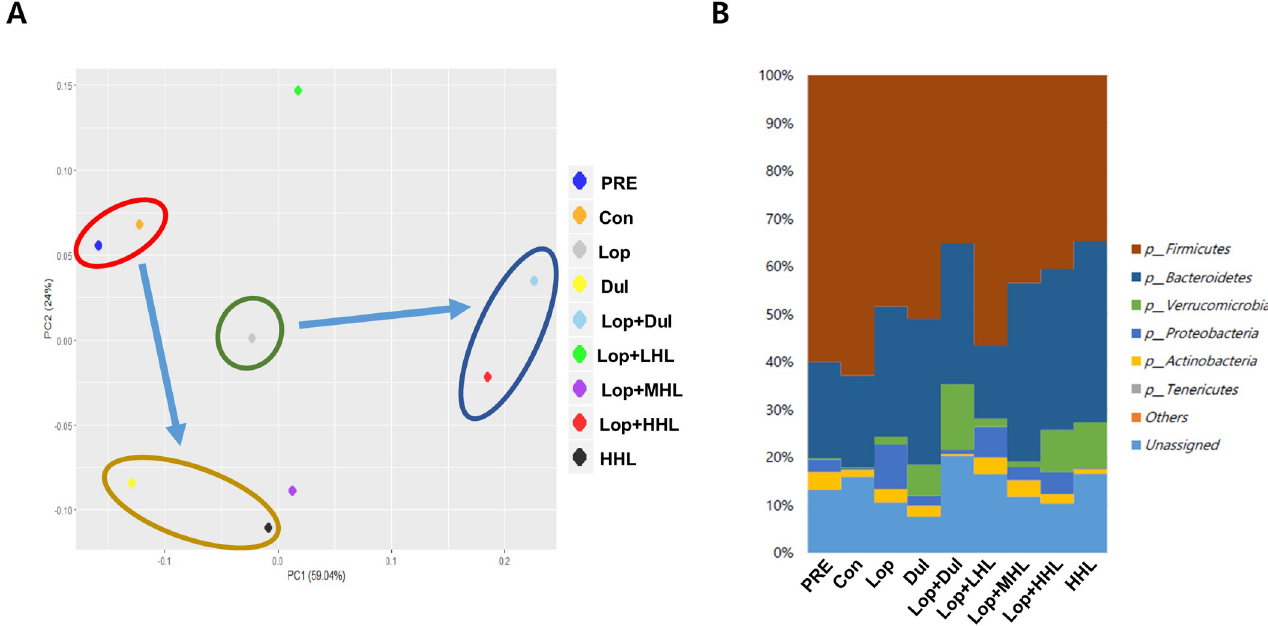
Fig 6. Changes of the genus pattern and microbiome composition in Extracellular Vesicles (EVs) and bacteria in rat feces. Eight-week-old rats were treated with loperamide along with 3.2 × 10 10 , 8 × 10 10 , and 1.6 × 10 11 cells/mL HLp-nF1, and Dulcolax, individually. A single treatment with 1.6 × 10 11 cells/mL HLp- nF1 or Dulcolax was used as the control. ( A ) The genus pattern in each group is graphically shown. The average relative density of the dominant bacterial phyla. ( B ) The X-axis shows the groups, and the Y-axis displays the average percentage of sequence reads. The cutoff point for selecting the dominant phyla was set at � 1%. “Others” indicates minor phyla, and “Unassigned” indicates non-identified phyla. PRE, pre-preparation group; Con , control group; Lop , loperamide- treated group; Dul , Dulcolax-treated group (0.75 mg/kg); HHL , treatment with 1.6 × 10 11 cells/mL HLp-nF1; Lop+LHL , treatment with loperamide and 3.2 × 10 10 cells/mL HLp-nF1; Lop+MHL , treatment with loperamide and 8 × 10 10 cells/mL HLp-nF1; Lop+HHL , treatment with loperamide and 1.6 × 10 11 cells/ mL HLp-nF1; Lop+Dul treated group.